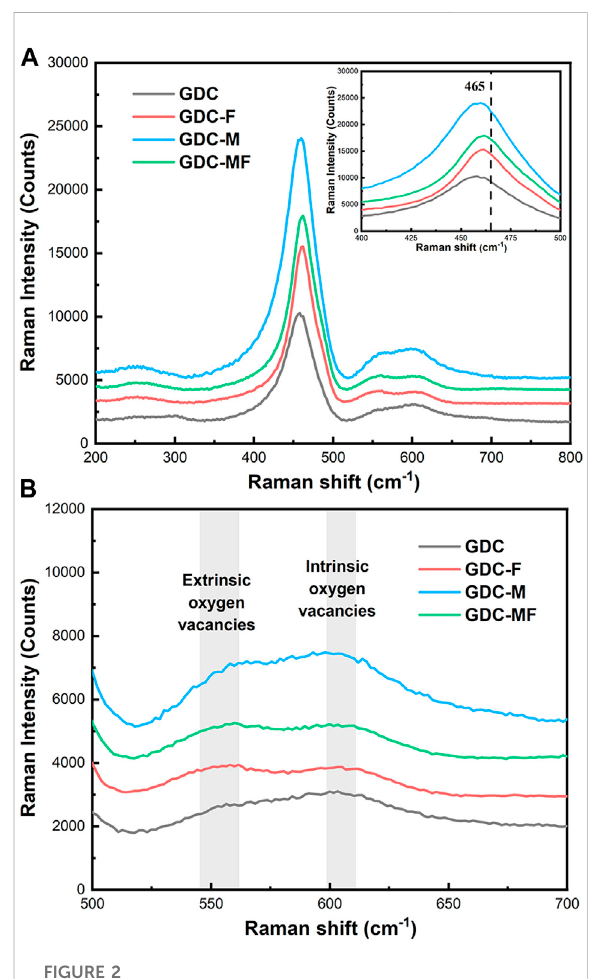
FIGURE 2 (A) Raman spectra of all samples, inset is the magni fi ed F 2g band and (B) Oxygen vacancy